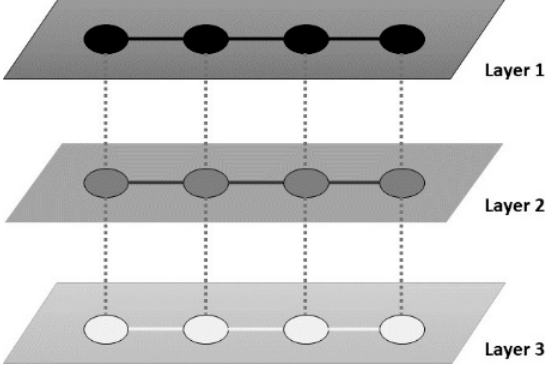
Figure 2. A three-layered example network. The solid lined edges in each layer are labeled as intralayer edges, the dotted lines crossed adjacent layers are labeled as interlayer edges.